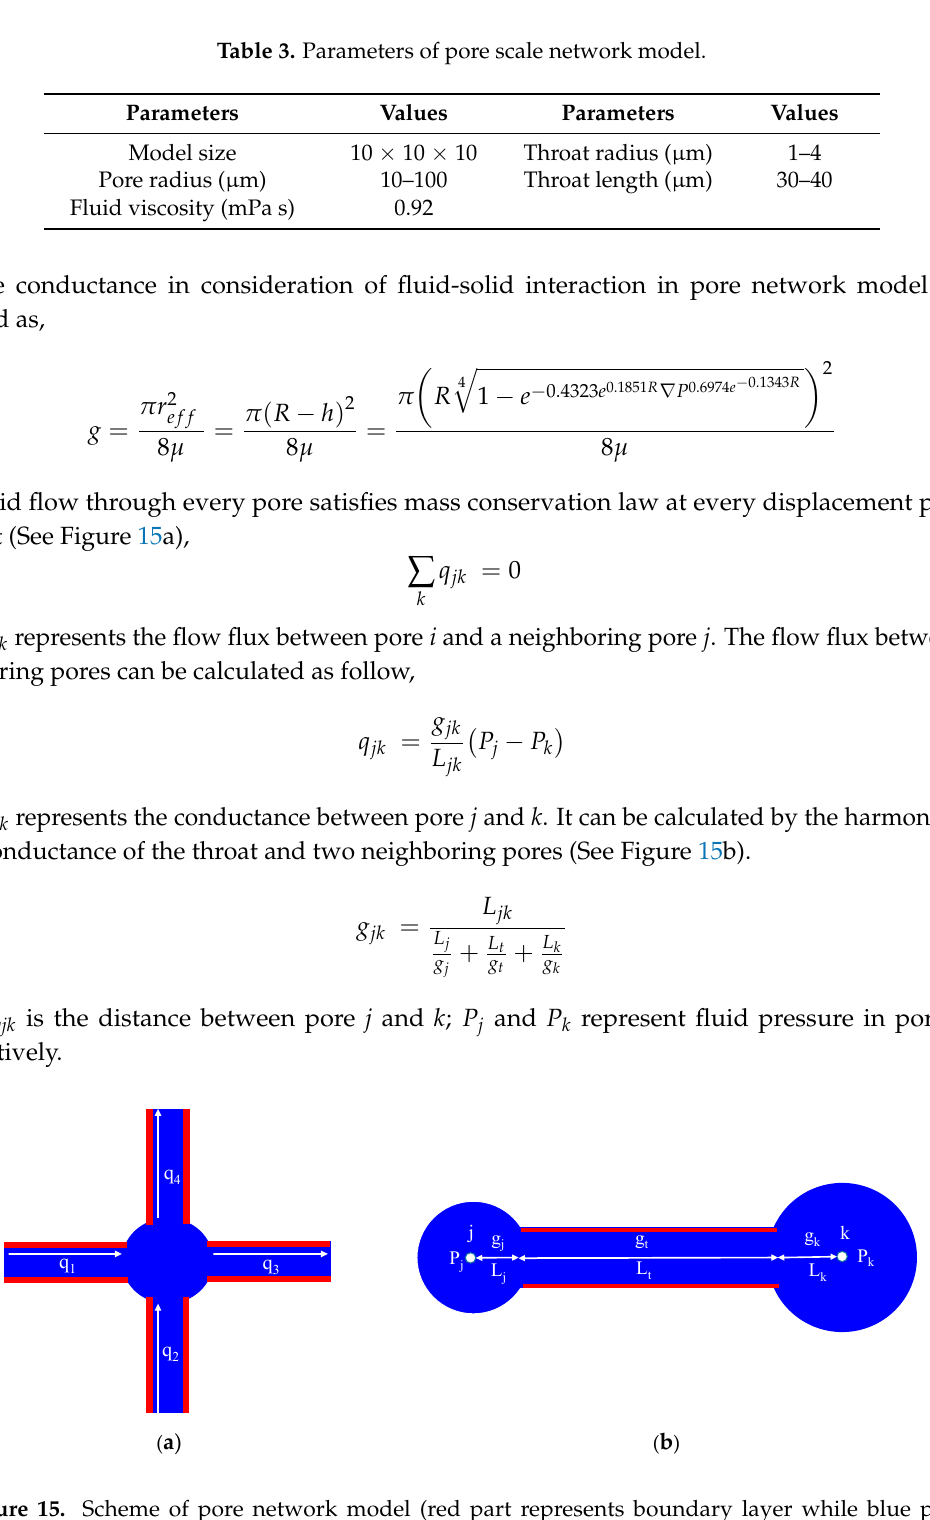
Table 3. Parameters of pore scale network model.